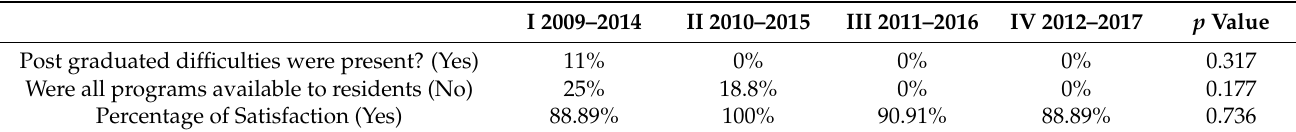
Table 2. Post-graduated satisfaction test results.